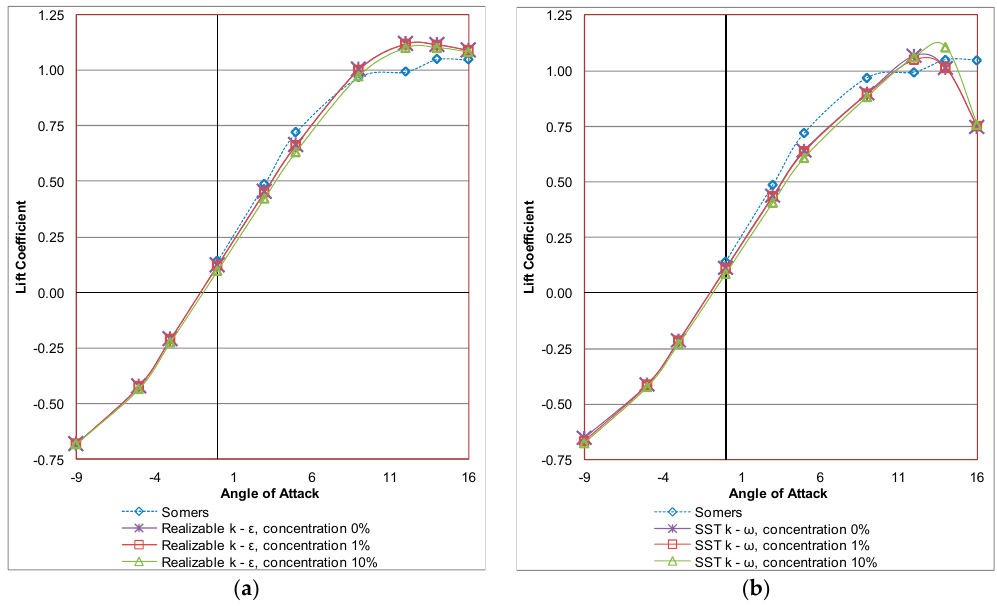
Figure 3. Comparison between reliable experimental data and simulation results of the lift coefficient curve for an S809 airfoil for ( a ) realizable k– ε ; and ( b ) SST k– ω turbulence models at Re = 1 × 10 6 for one-phase and two-phase flows consisting of two different concentrations of sand particles in the air.